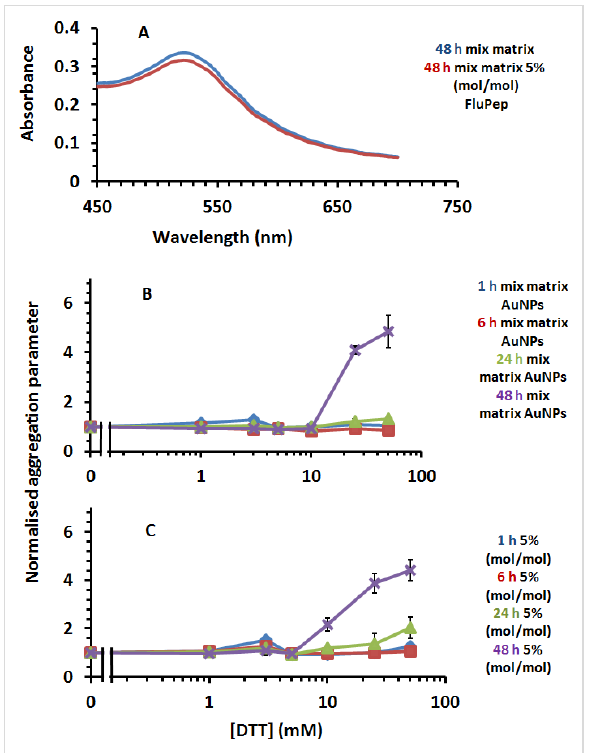
Figure 1: Stability of gold nanoparticles to DTT ligand exchange. (A) UV–vis spectra of mixed-matrix-capped gold nanoparticles and mixed-matrix-capped gold nanoparticles incorporating 5% (mol/mol) FluPep ligand in PBS. Time- and dose-dependence of DTT ligand exchange for (B) mixed-matrix gold nanoparticles and (C) gold nano- particles with a ligand shell incorporating 5% (mol/mol) FluPep ligand. Results in (B) and (C) are the mean ± SD ( n = 3).